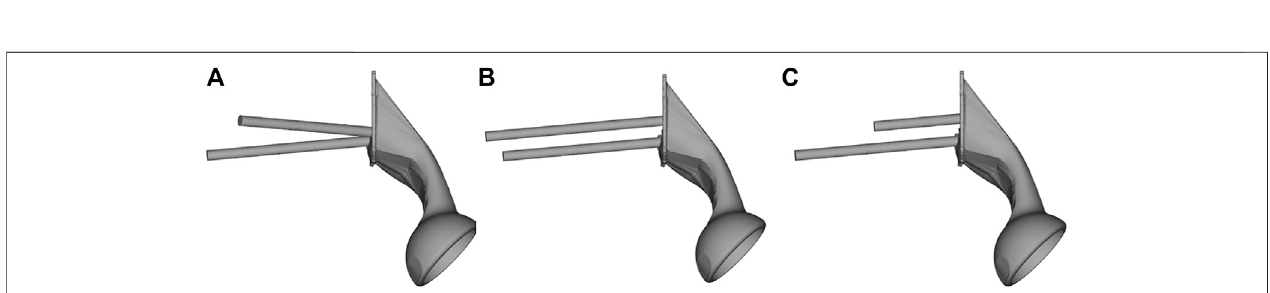
FIGURE1 | Sectional diagram ofsevenlayersofsacral sagittal plane and themeasurementmethod ofBMD. (A) a: The junction oftheleft auricular surfaceand the dorsalside.b:Middleoftheleftsacralwing.c:Leftmarginofthesacralcanal.d:Mediansacralline.e:Rightmarginofthesacralcanal.f:Middleoftherightsacralwing.g: Therightauricularsurfaceisatthejunctionwiththedorsalside. (B) Thesagittalplaneisdividedintofourregions,andthebonemineraldensityofeachregionismeasured with a region-of-interest tool in the OsiriX Lite software.